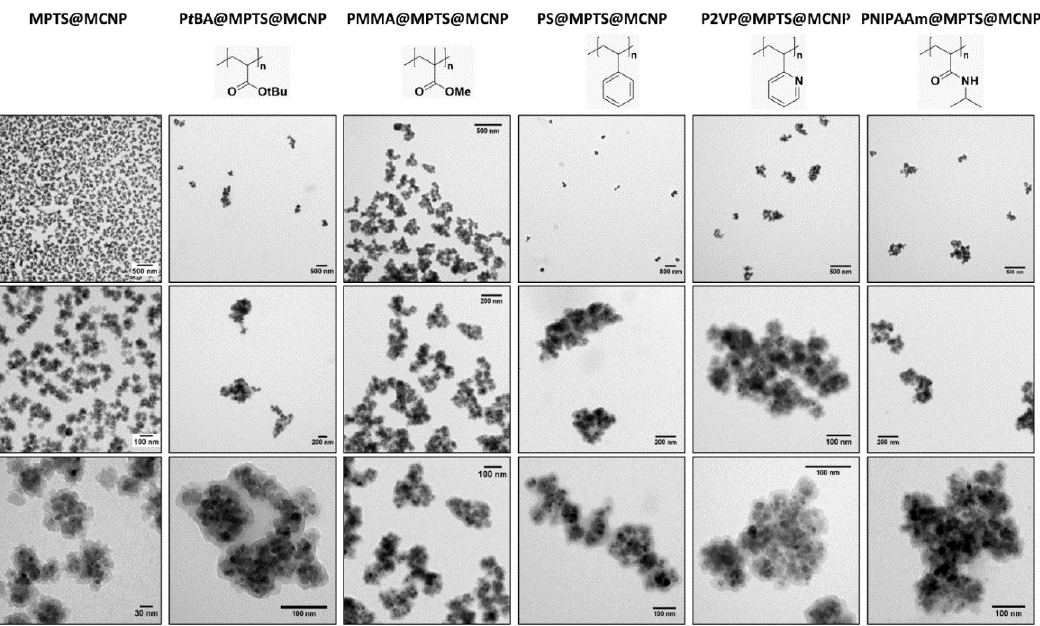
Figure 6. TEM micrographs of di ff erent polymer@MPTS@MCNP obtained from polymerizations in the presence of MPTS@MCNP as chain transfer agent at di ff erent magnification. Table 2. Mass loss between 200 and 800 °C under synthetic air and hydrodynamic radius of